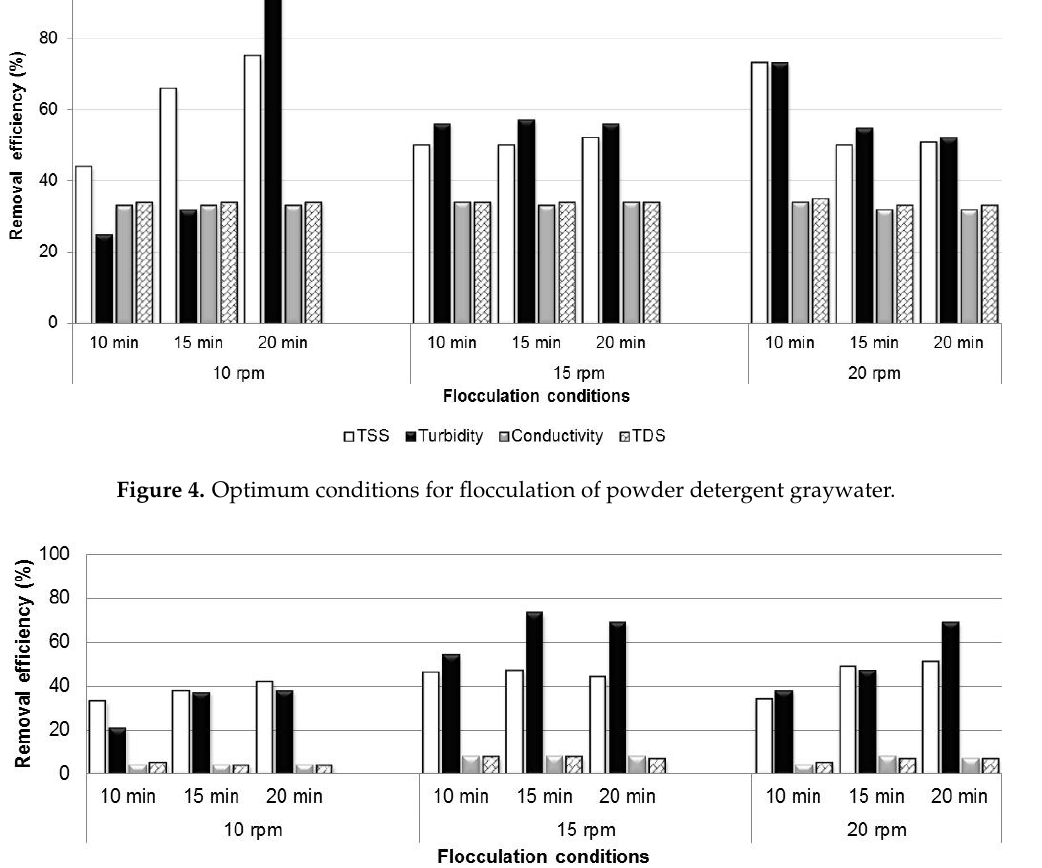
Figure 3. Effect of coagulant dosage (mg/L) on bulk parameters removals for both graywaters. PD: Powder detergent; LD: Liquid detergent.